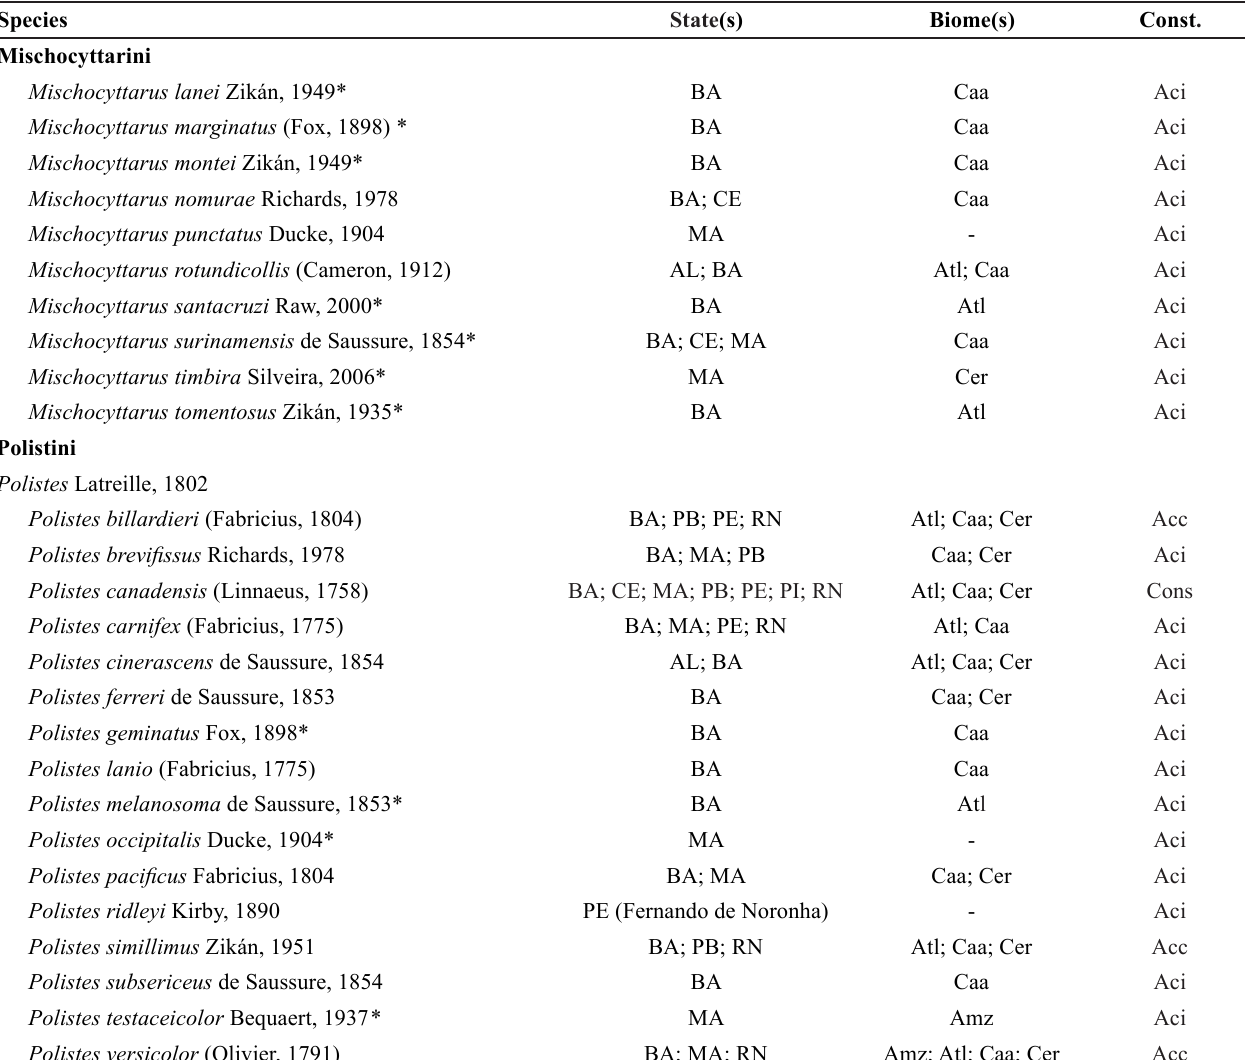
Table 2 . Species of Social Wasps registered in Northeastern Brazil. States: AL: Alagoas; BA: Bahia; CE: Ceará; MA: Maranhão, PB: Paraí- ba; PE: Pernambuco; PI: Piauí; RN: Rio Grande do Norte. Biomes: Atl: Atlantic Forest; Amz: Amazon Forest; Caa: Caatinga; Cer: Cerrado. Constance: Acc: Accessory; Aci: Accidental; Cons: Constant. *New species records after Richards (1978). (Continuation)